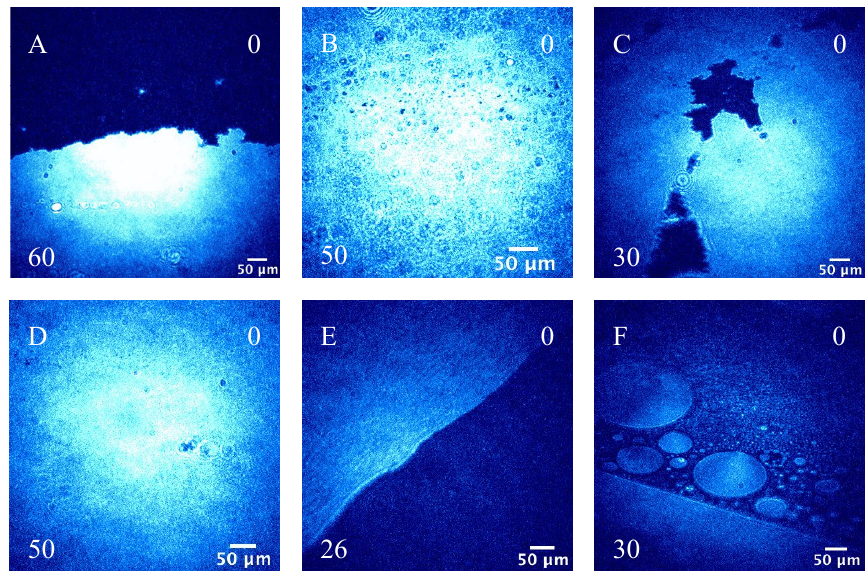
Figure 10. BAM images of the G-LC coexistence region of mixed PA/cerebrosides monolayers for various compositions: ( A ) 0:1; ( B ) 1:4; ( C ) 2:3; ( D ) 3:2; ( E ) 4:1; ( F ) 1:0. Mean molecular area (Å 2 /molecule) and surface pressure (mN/m) values are indicated in the bottom left and top right corners,